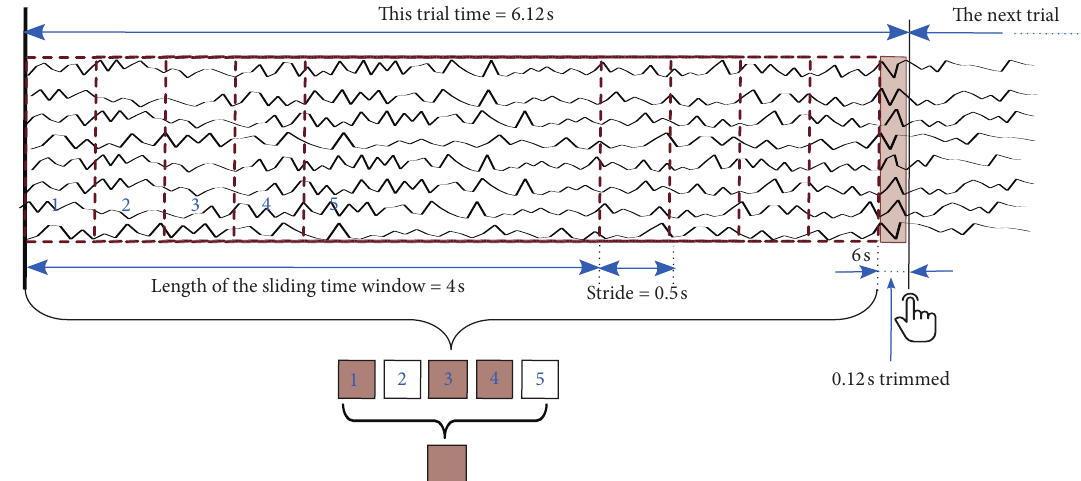
Figure 4: Trimming strategy in quorum voting to avoid a